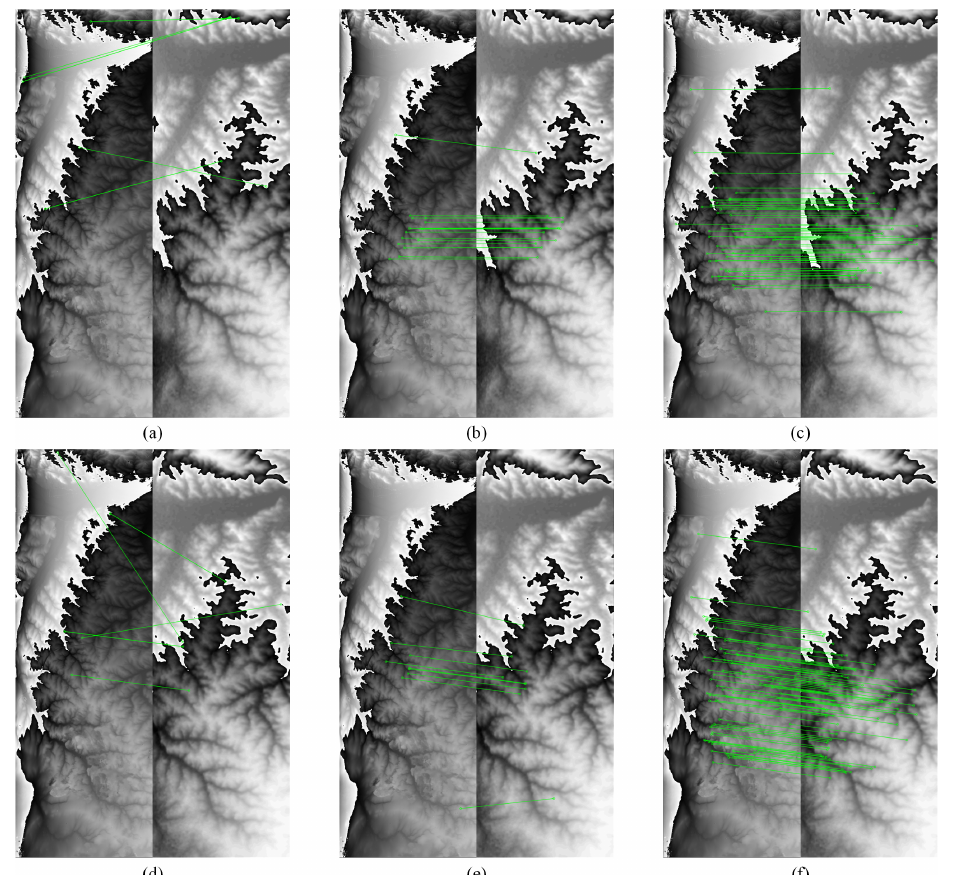
Figure 17. Comparison of interference fringe-matching algorithm results in the position error experi- ment. ( a – c ) Without error. ( d – f ) With error. ( a , d ) SIFT. ( b , e ) SURF. ( c , f ) Proposed